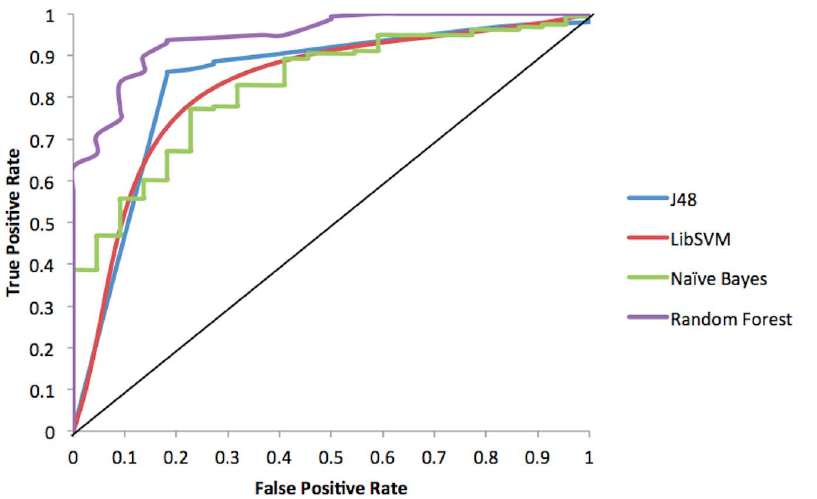
Figure 4. ROC curves for the predictive performance of different cost sensitive classifiers. ROC plot depicts a relative trade-off between true positive rate and false positive rate of the predictions. The diagonal value represents a completely random guess. The corresponding scalar values of area under curve are given as auROC in table 4.